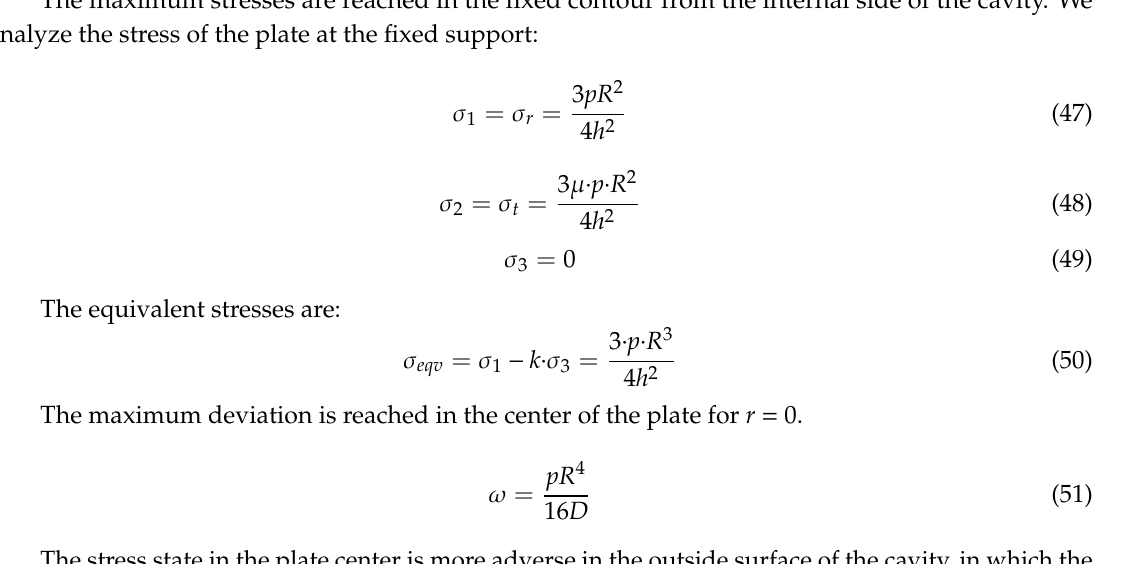
Figure 5. Bending-momentum diagrams of the system for ( a ) radial and ( b ) tangential.